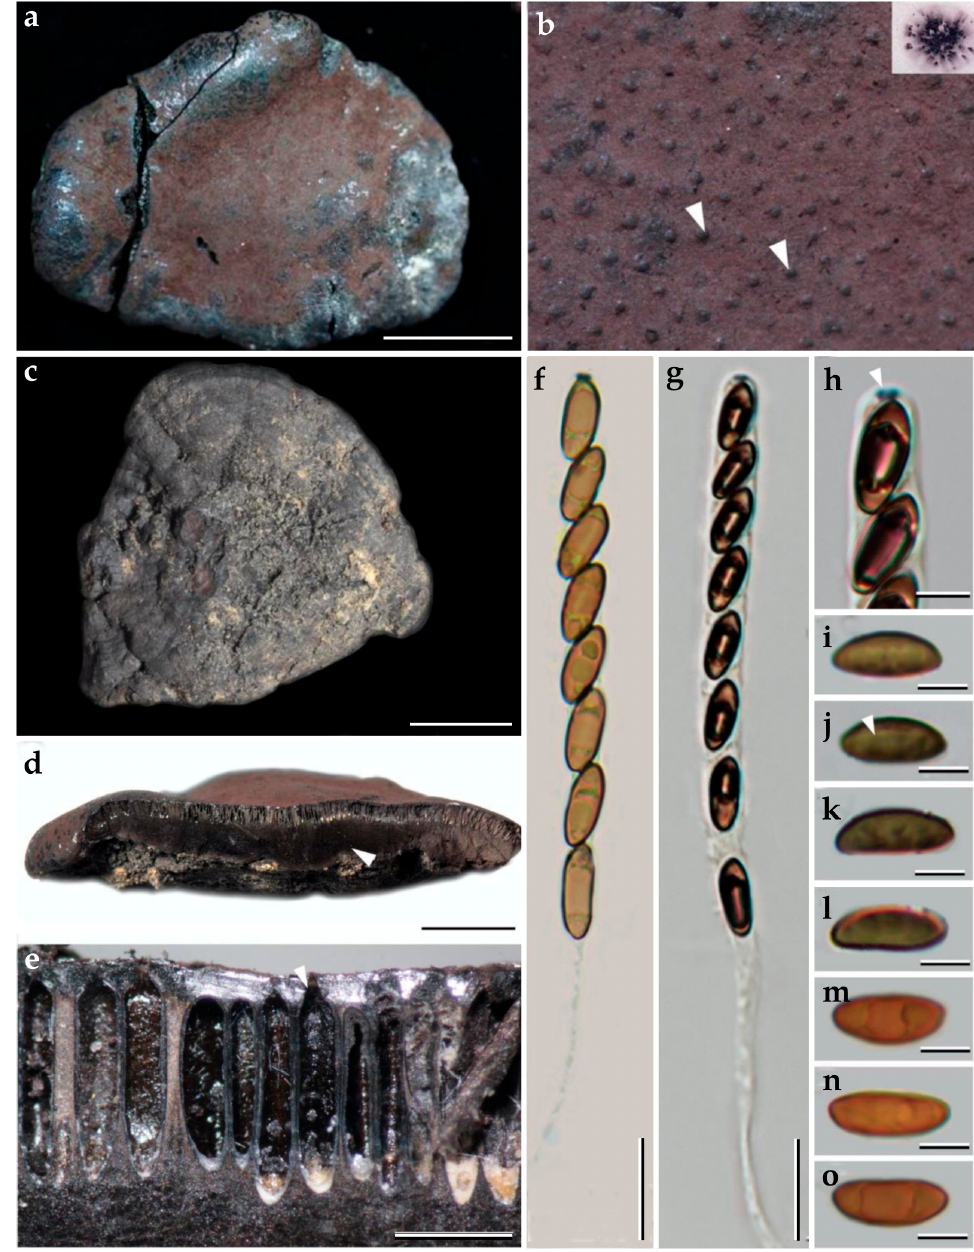
Figure 10. Morphological characteristics of Pyrenopolyporus papillatus (BBH15197). ( a ) Stroma; ( b ) stromatal surface showing ostiole (white arrows) and KOH-extractable pigment; ( c ) detail of stromal insertion point; ( d ) longitudinal section showing the tissue below the perithecial layer (arrow); ( e ) Perithecia (arrow); ( f , g ) asci in Melzer’s iodine regent; ( g ) apical apparatus bluing in Melzer’s reagent (arrow); ( i – l ) ascospores in 10% KOH with showing germ slit (arrow); ( m , n ) ascospore in distilled water. Scale bars: ( a , b ) = 1 cm; ( d ) = 5 mm; ( e ) = 0.5 mm ( f , g ) = 20 µm; ( h – o ) = 5 µm.